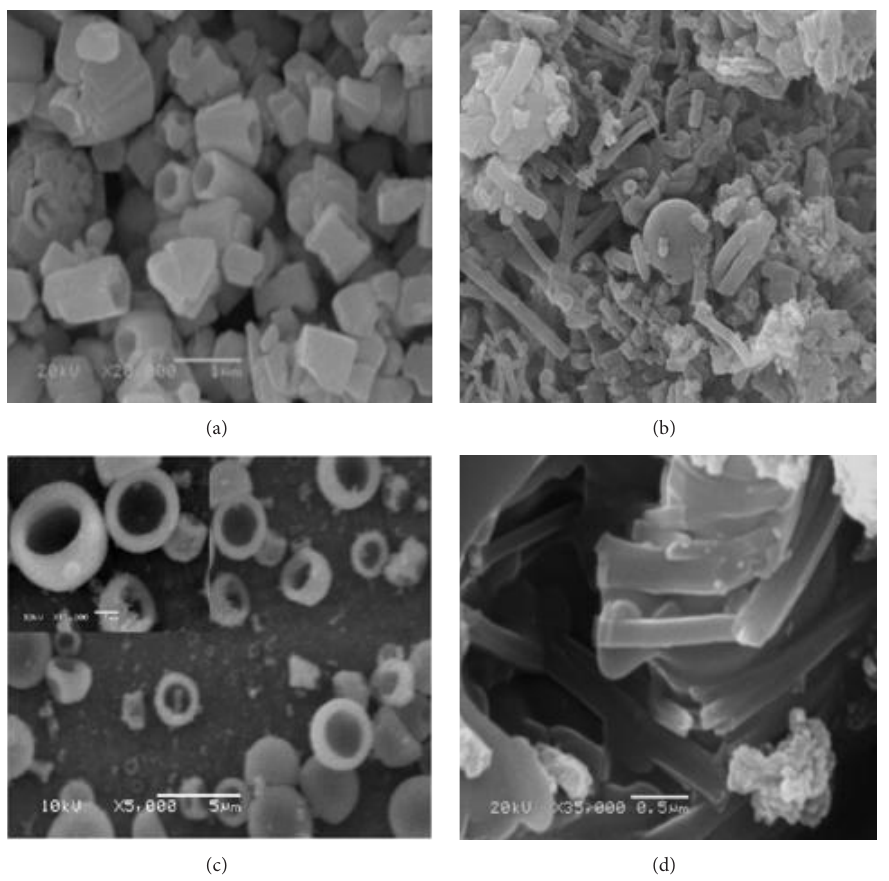
Figure 16: SEM micrographs of ZnO nanotubes after and before annealing at different temperatures: (a) as prepared, (b) 500 ∘ C annealing, (c) 700 ∘ C annealing, and (d) 900 ∘ C